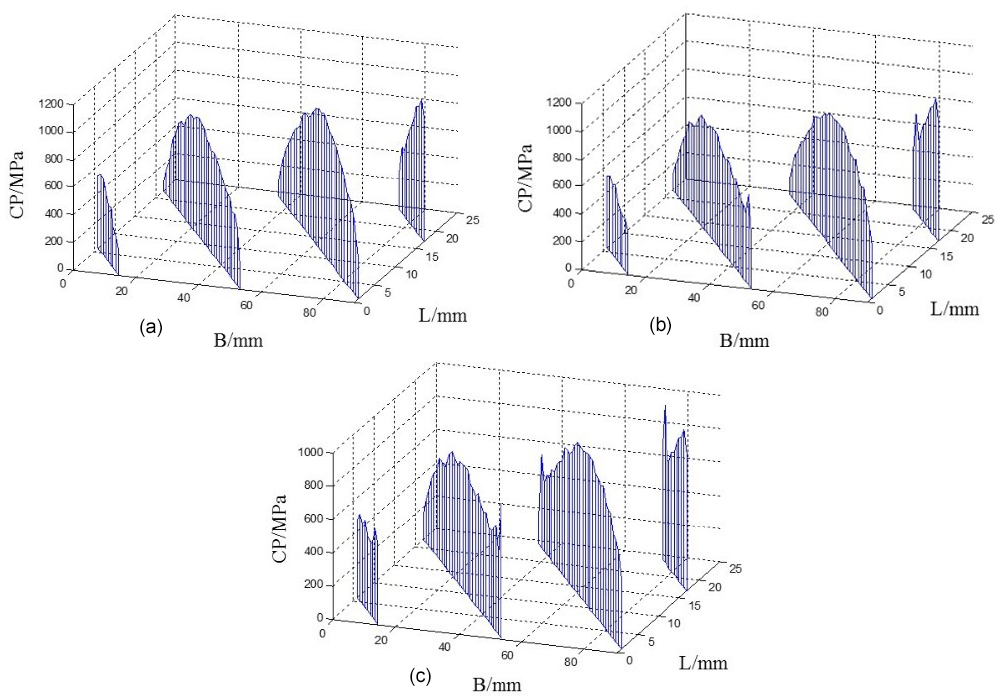
Figure 23. Contact stress distribution of the right tooth surface with three different modification values of the Z -shaped power flow. (a) Maximum amount of modification at 37µm. (b) Maximum amount of modification at 28.5µm. (c) Maximum amount of modification at